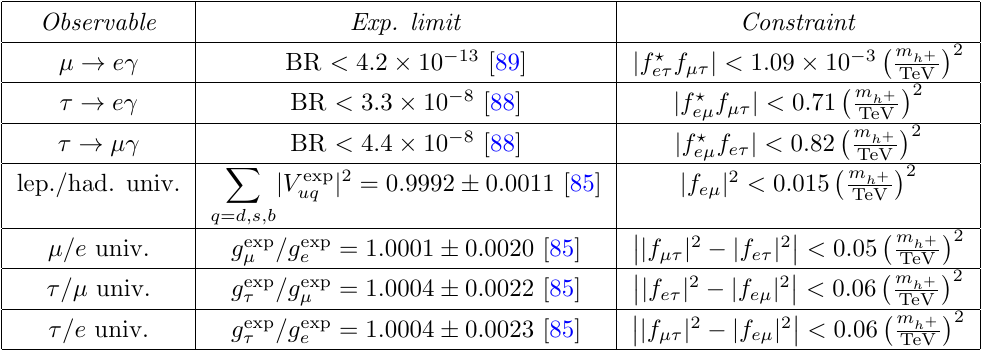
stands for (cid:11)